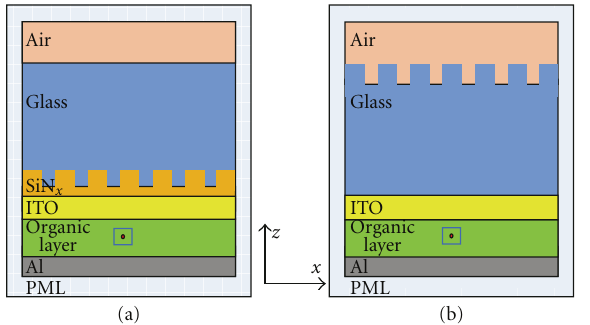
Figure 2: Schematics of OLED structure with (a) embedded PhCs between the ITO layer and the substrate (b) surface PhCs etched on the substrate.